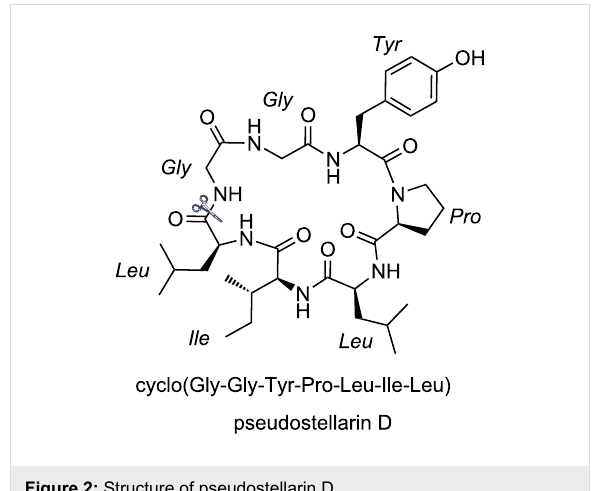
Figure 2: Structure of pseudostellarin